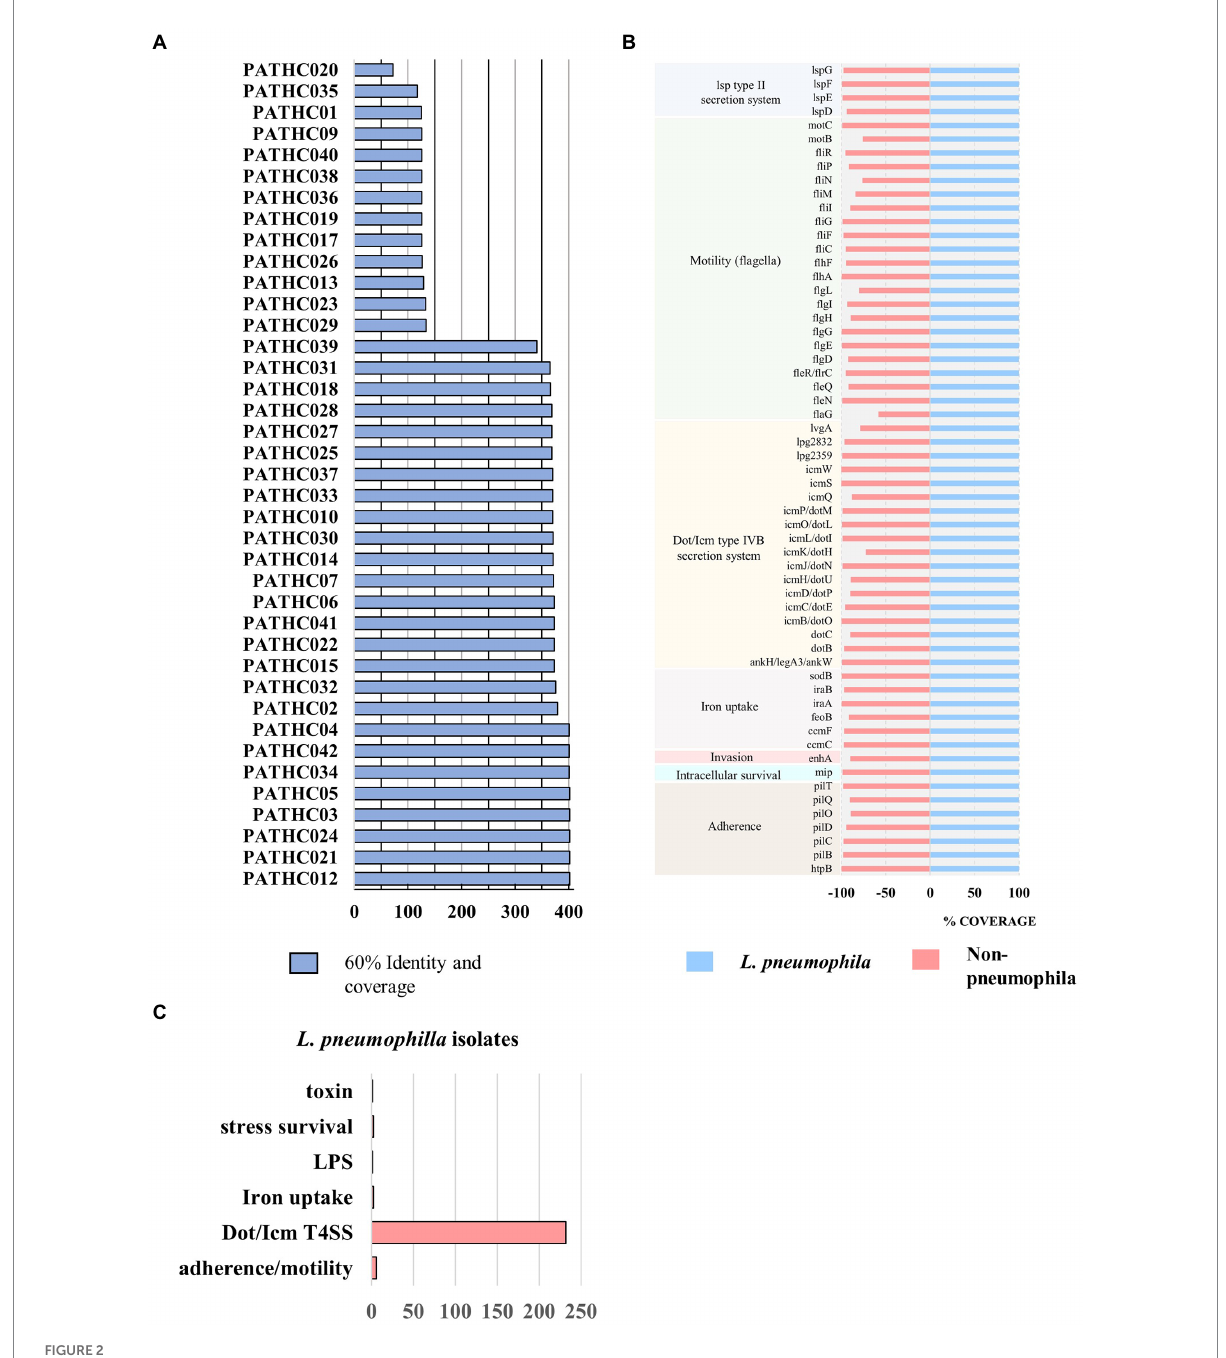
FIGURE 2 Results of the virulence factor search against VFDB. Coverage represents percentage of the gene covered and identity percentage of exact nucleotide matches. (A) The number of putative virulence factors in the isolates displaying 60% coverage and 60% identity to virulence factors in the VFDB. (B) Virulence genes shared among all isolates sequenced in this study. (C) Biological role of virulence factors only found in Legionella pneumophila isolates compared to non-pneumophila